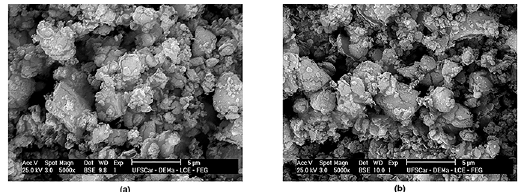
Figure 4. SEM micrographs (BSE images) for the nanocomposites: (a) MgH